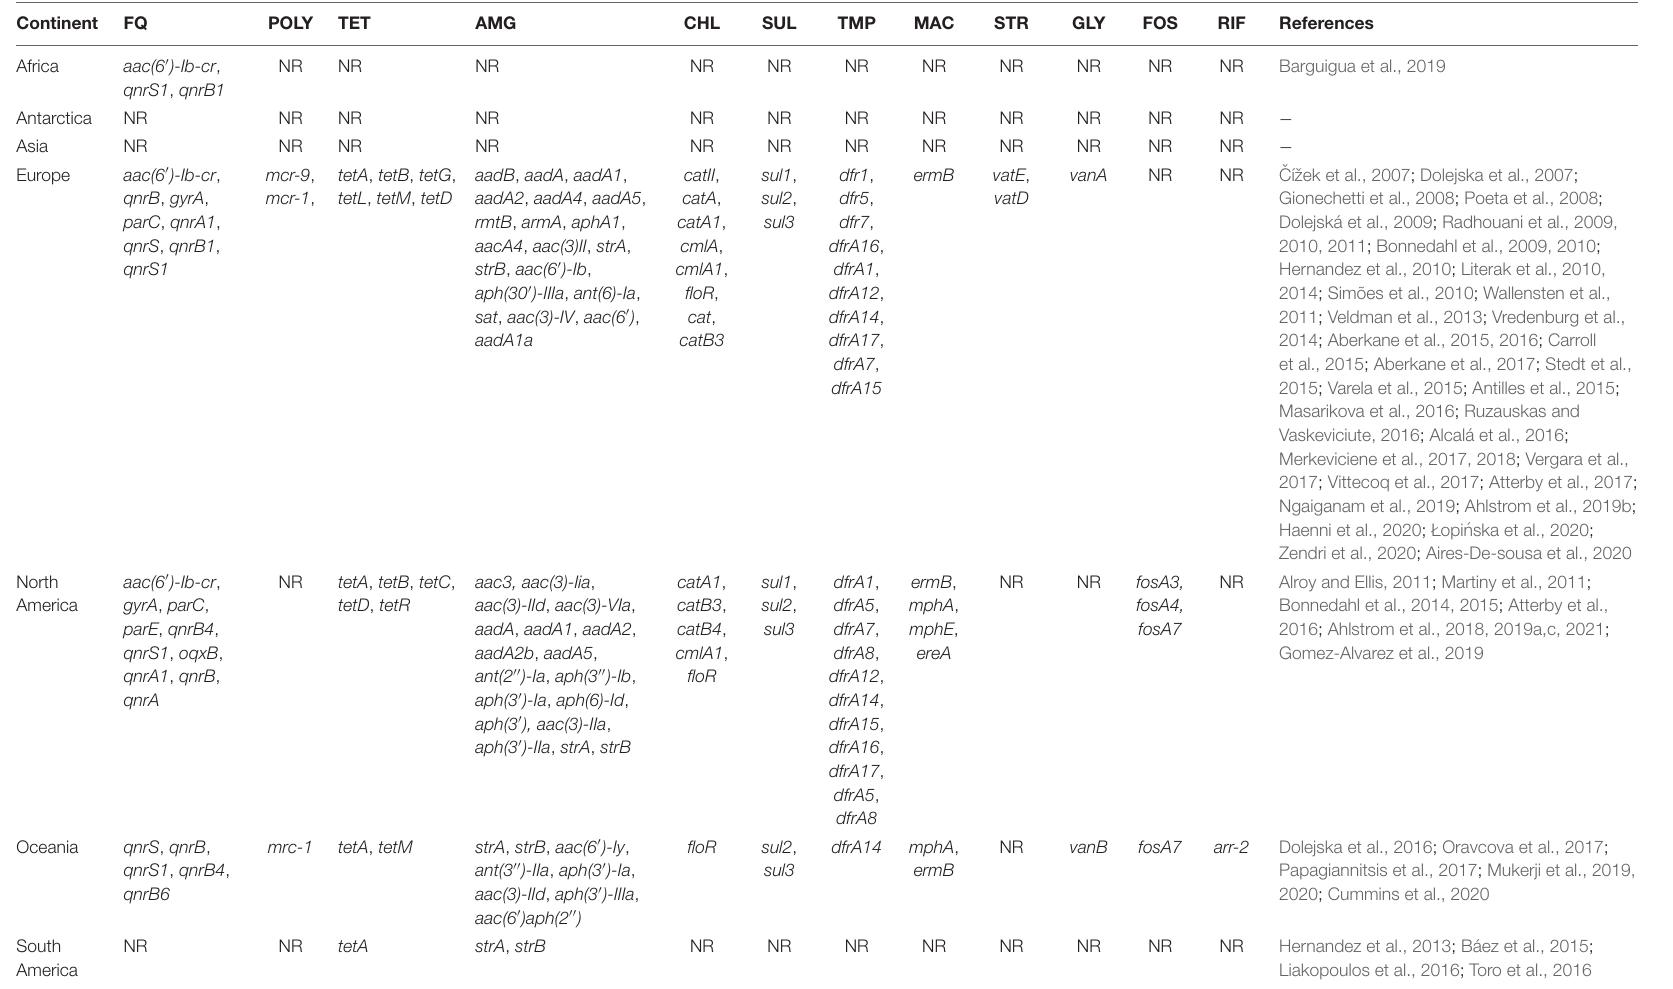
TABLE 4 | AMR genes identified in isolates from gulls reported between 1981 and 2020.